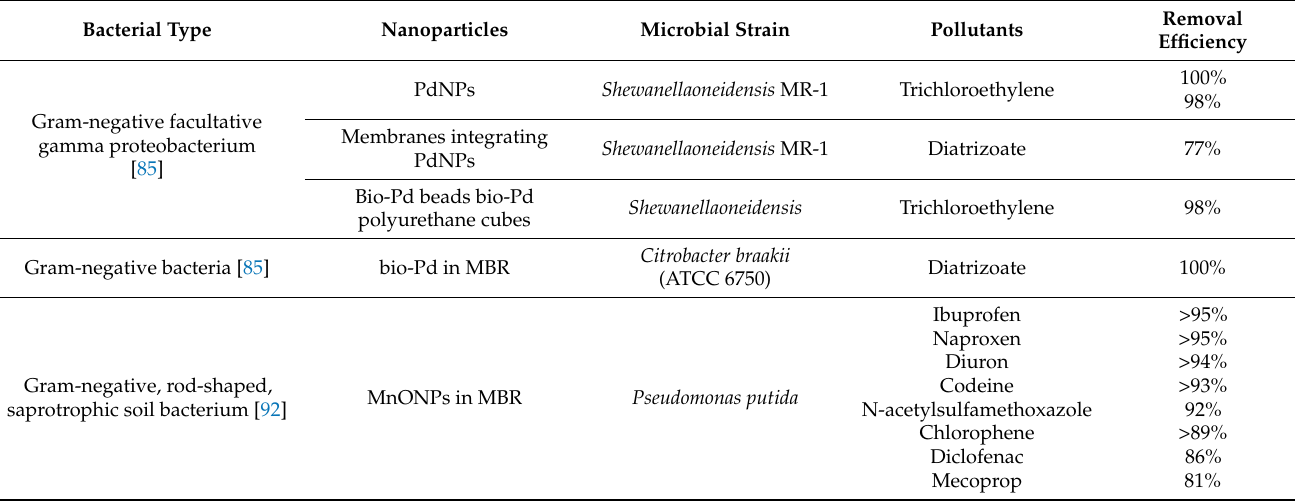
Table 4. Commercialized microbial NPs inbuilt bioreactor for wastewater